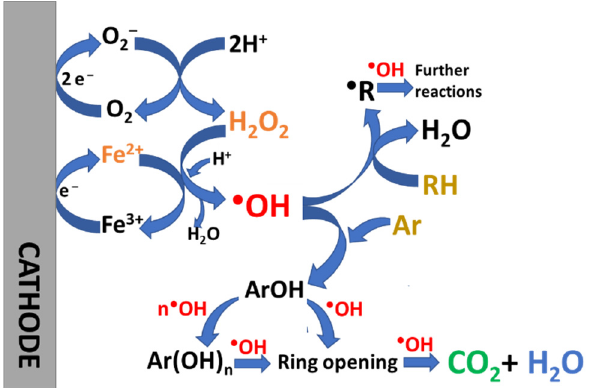
Figure 8. Schematic representation of the main reactions involved in the EF process. The Ar and RH illustrate aromatic and unsaturated compounds that react with hydroxyl radical in the bulk.